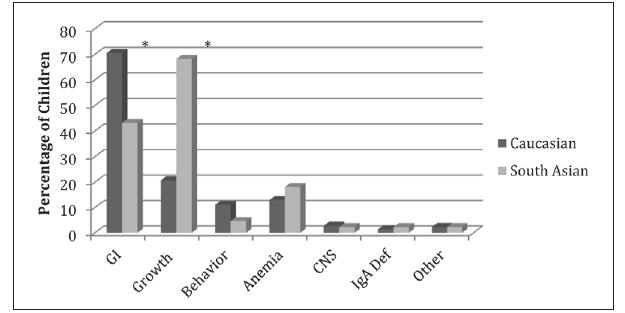
Figure 1) Comparison of symptom presentation between Caucasian and South Asian patients referred for diagnosis of celiac disease at the Stollery Children’s hospital in Edmonton, Alberta. *P<0.001. CNS Central nerv- ous system; Def Deficiency; GI Gastrointestinal; IgA Immunoglobulin A